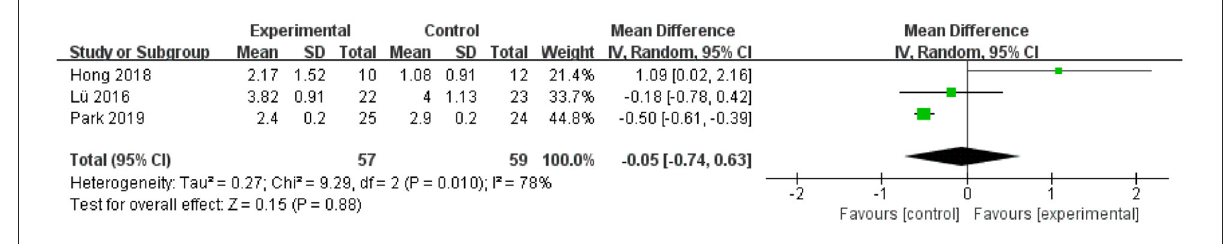
FIGURE4 The influence of exercise interventions on working memory.